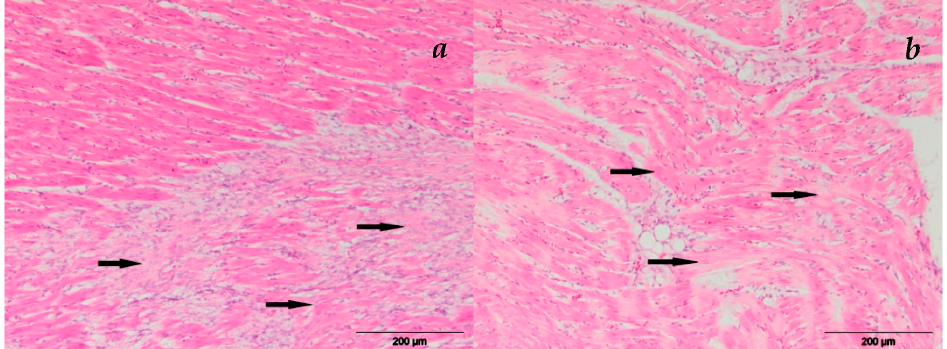
Figure 3. Heart myocardial degeneration, HE staining: ( a ) group E-V; ( b ) group E-VI .